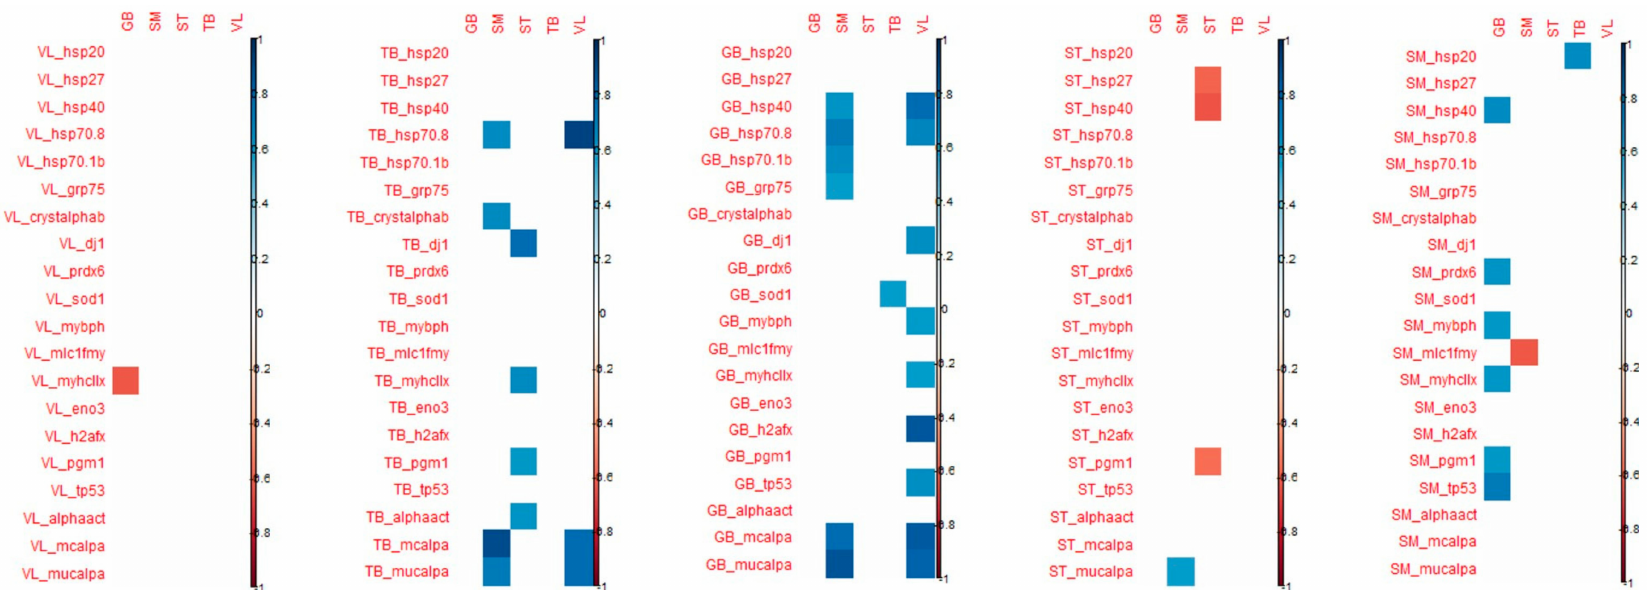
Figure 4. Correlations demonstrated between the tenderness of each of the 5 muscles (in column) and the 20 biomarkers of each muscle (in-line). Only the coe ffi cients that were significant (corresponding to those that were superior or equal to 0.55 / inferior or equal to − 0.55) are indicated (positive correlations in blue and negative ones in